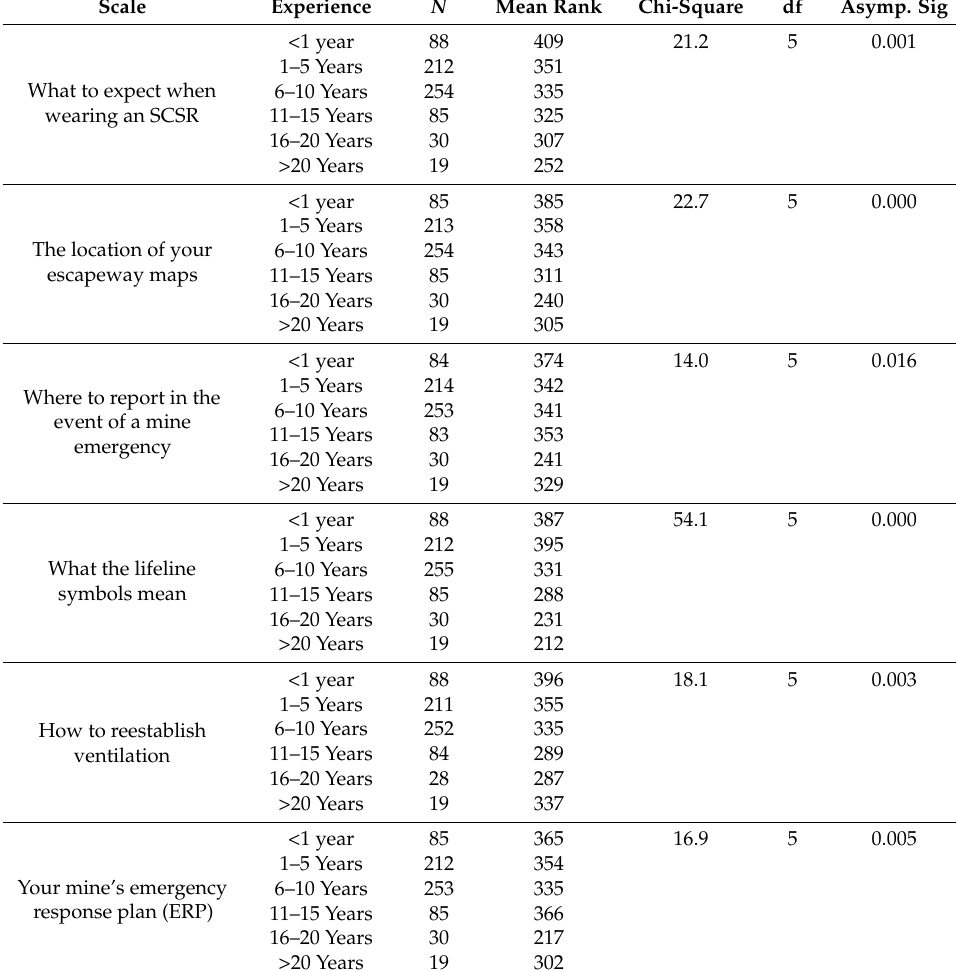
Table 4. Kruskal-Wallis results for six self-escape competency items (only significant differences